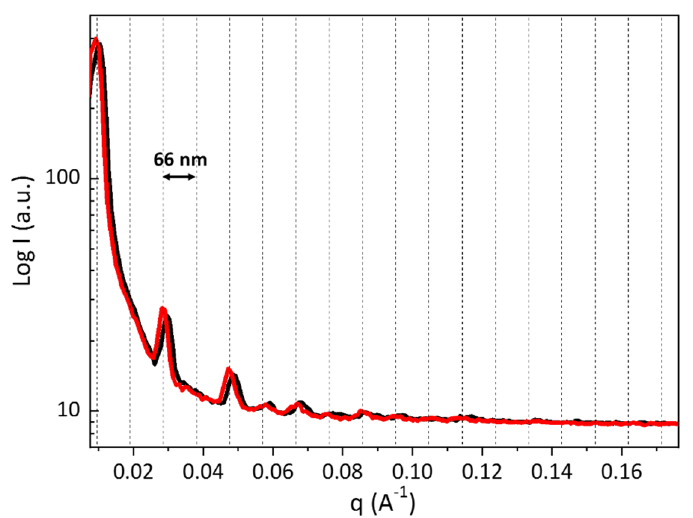
Figure 5. One-dimensional SAXS diffraction profiles obtained from radial integration of TG_4M_CTRL (black profile) and TG_4M_TRAT (red profile). The black dotted lines mark the periodicity along the fibril axis of ~65–66 nm ± 2 nm.